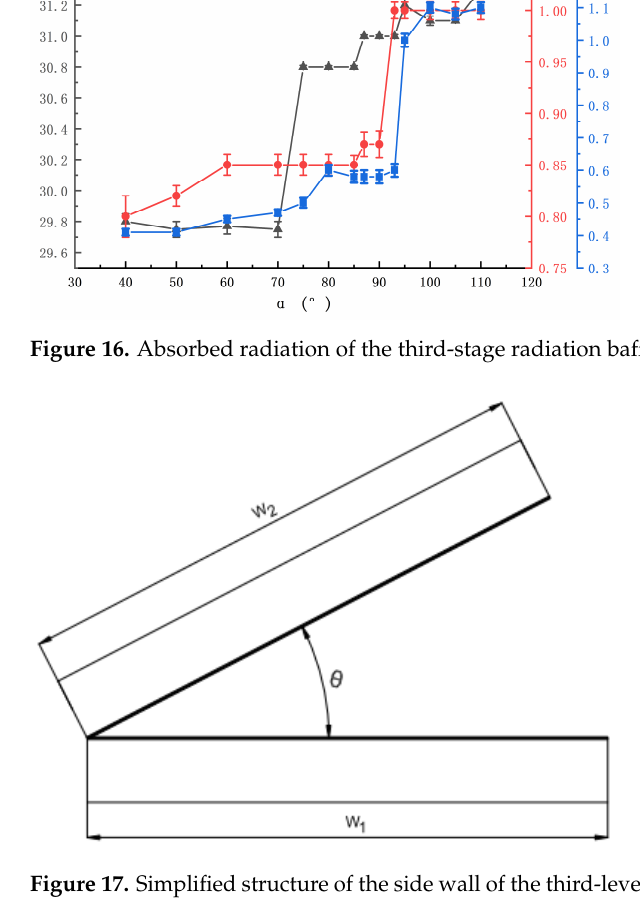
Figure 17. Simplified structure of the side wall of the third-level radiation baffle and emitting sur- face.